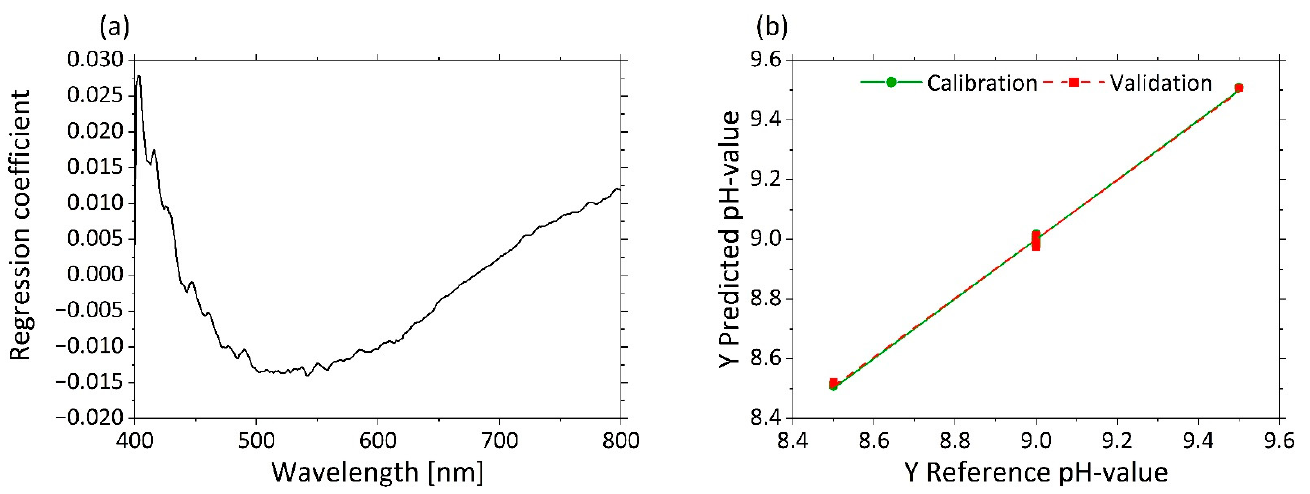
Figure A1. PLS-R with three factors for pHs at 10% MWF concentration values on µ’ s -spectra. The regression coefficients of the three-factor model are shown in ( a ). Predicted vs. reference of pHs for calibration (green) and validation (red) are displayed in ( b ).